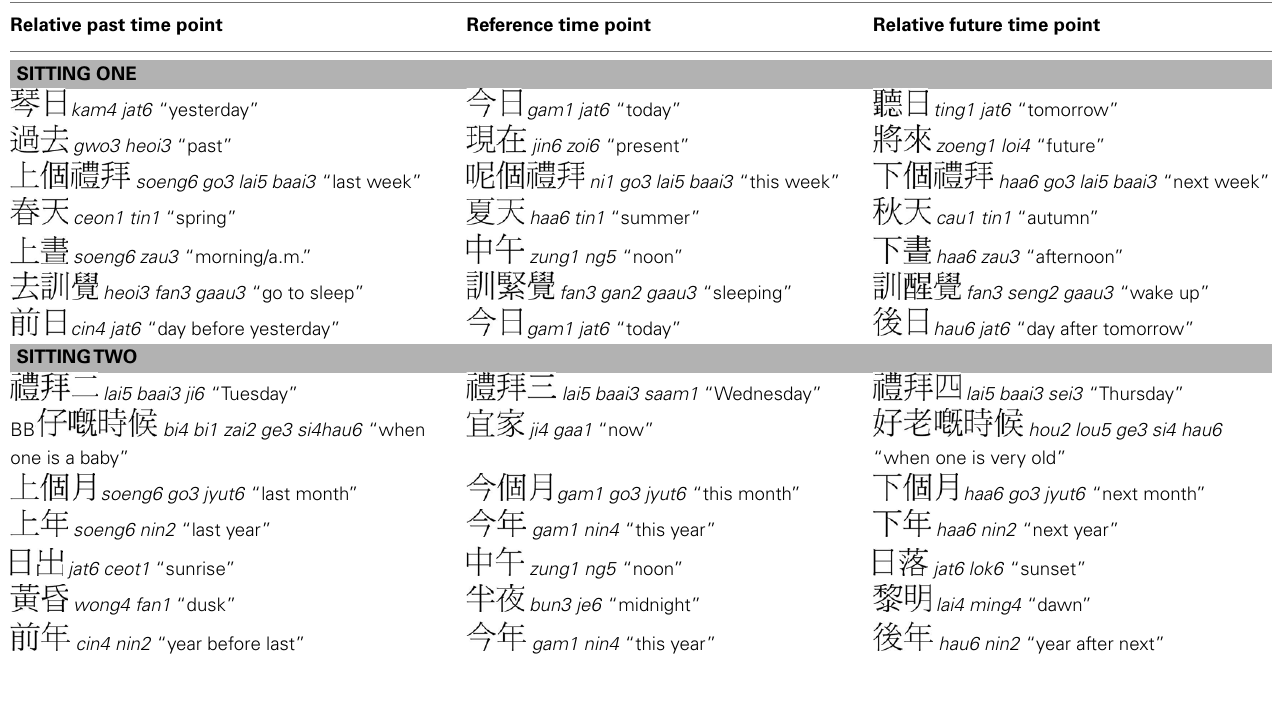
Table 1 |The fourteen sets of temporal expressions used in the time-points task. Relative past time